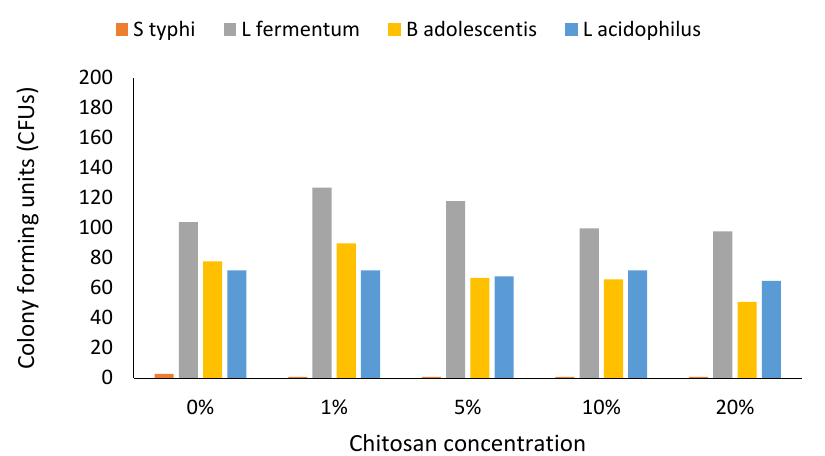
Figure 2. Effect of bacterial growth on chitosan-amended media in the presence of probiotic-prebiotic at a ratio of 1:1 (24HRS). n = 3. Abbreviation: S typhi: Salmonella typhi , L fermentum: Lactobacillus fermentum , B adolescentis: Bifidobacterium adolescentis , L. acidophilus: Lactobacillus acidophilus. Bacterial growth in 0%, 1%, 5%, 10% and 20% chitosan-supplemented media was monitored at 24 h. Bacterial growth was measured in colony-forming unit per millilitre (CFU/mL).